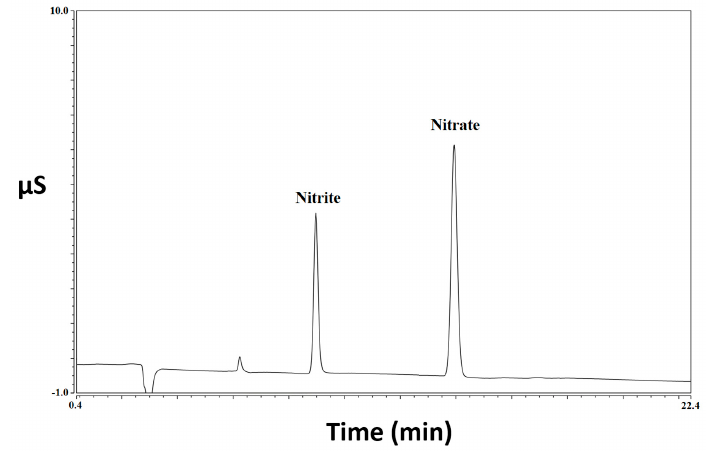
Figure 2. Chromatogram of a standard solution at a concentration of 5.0 mg L − 1 of nitrite and nitrate.